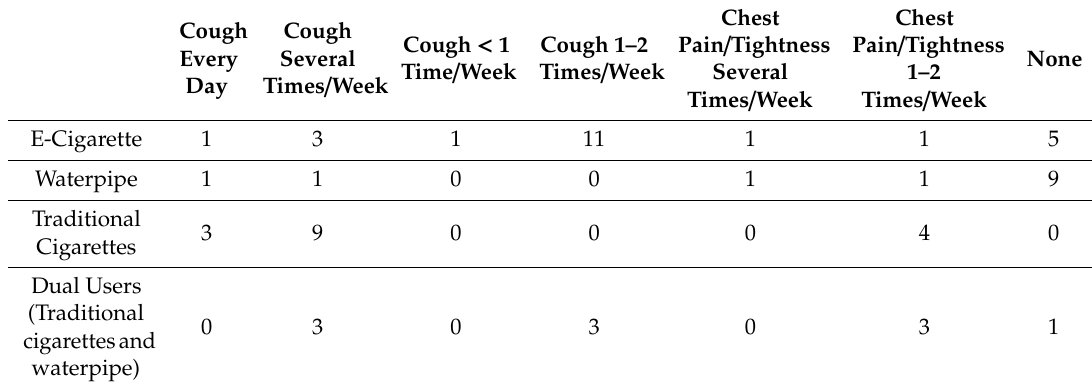
Table 1. Clinical symptoms experienced by e-cigarette and tobacco users.